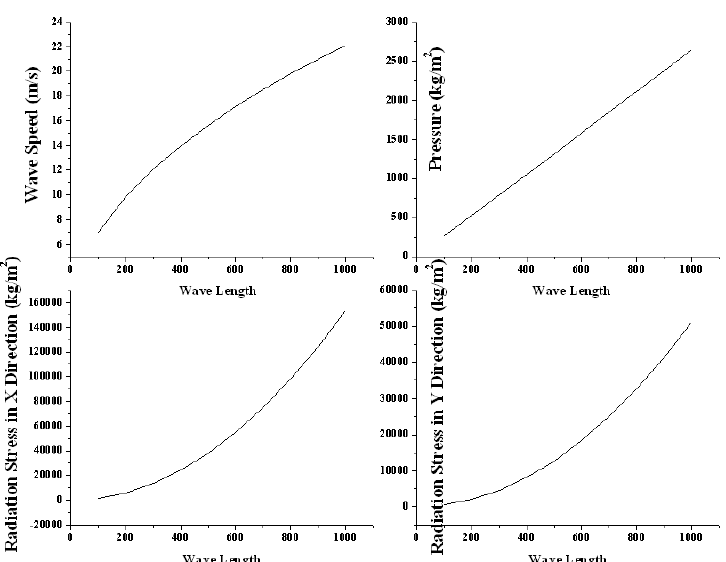
Table 2: Mathematical characteristics of wave in shallow water.